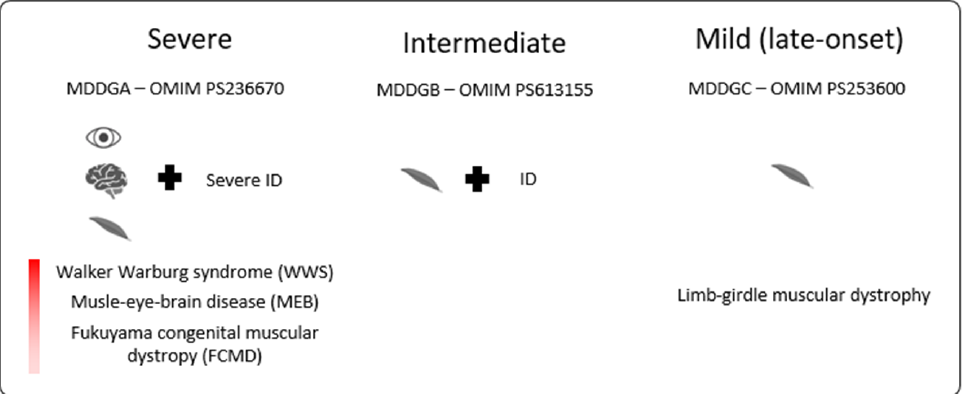
Figure 1. A wide spectrum of clinical severity is observed in patients with dystroglycanopathies. MDDGA is the most severe phenotype and involves patients diagnosed with WWS, MEB, and FCMD based on eye, muscle, and brain anomalies. MDDGB patients have a milder phenotype with muscle and neurodevelopmental delays but without eye or structural brain anomalies. The last group at the mildest end of the spectrum is characterized by limb-girdle muscular dystrophy, mostly seen in late-onset disorders.